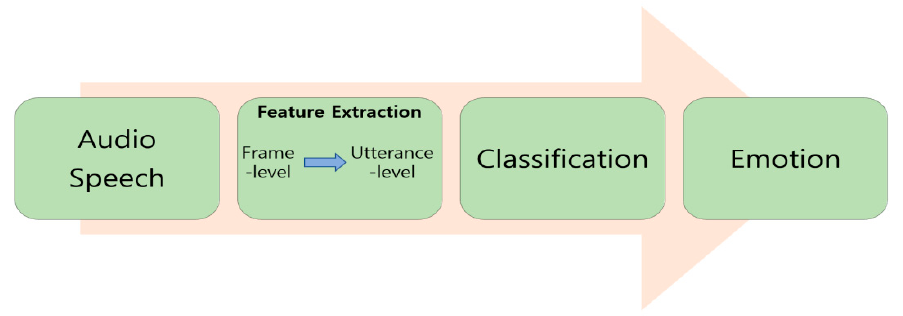
Figure 1. Steps of classic SER systems.